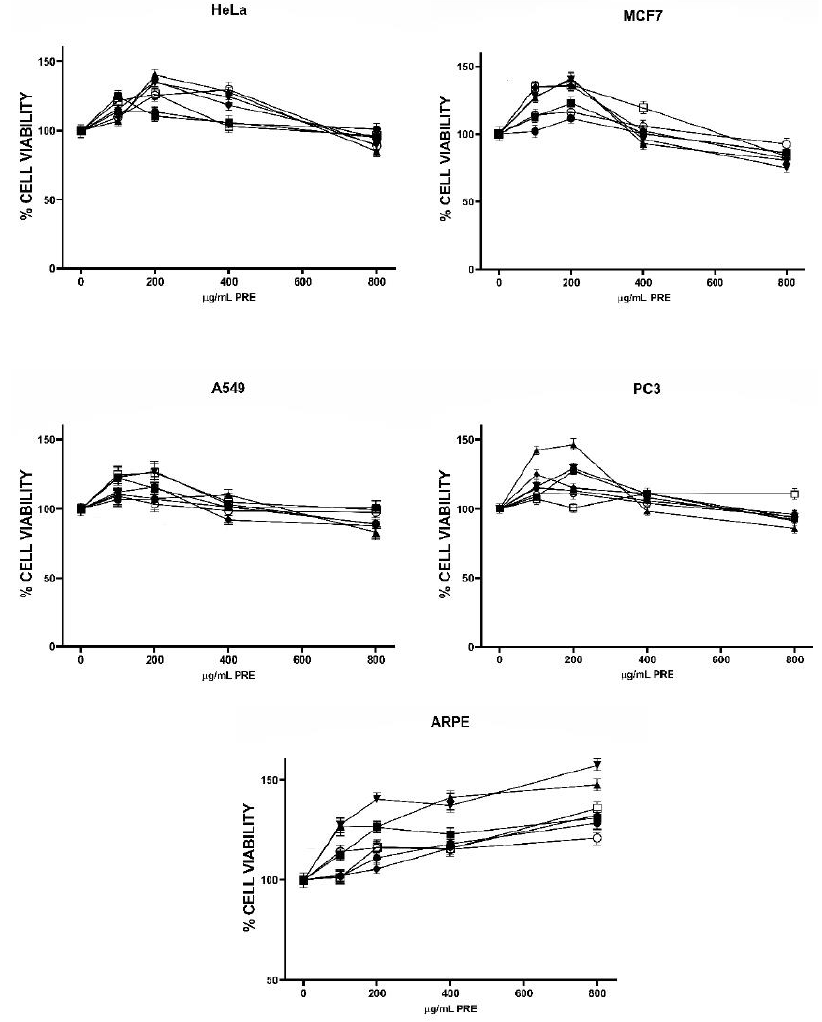
Figure 2. Effect of phenols-rich extracts (PRE) on viability cancer cells. Almond (ALM ), Emory oak acorn (EOA ), Pecans (PEC ), Pine nut pink (PPN ), Pine nut white (PNW ), Pistachio (PIS ), Walnut (WN).